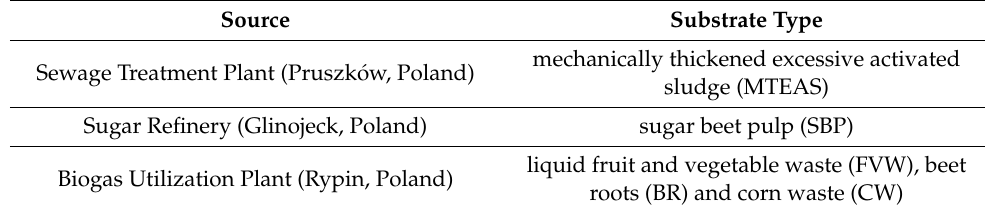
Table 3. Types of substrates and their sources.